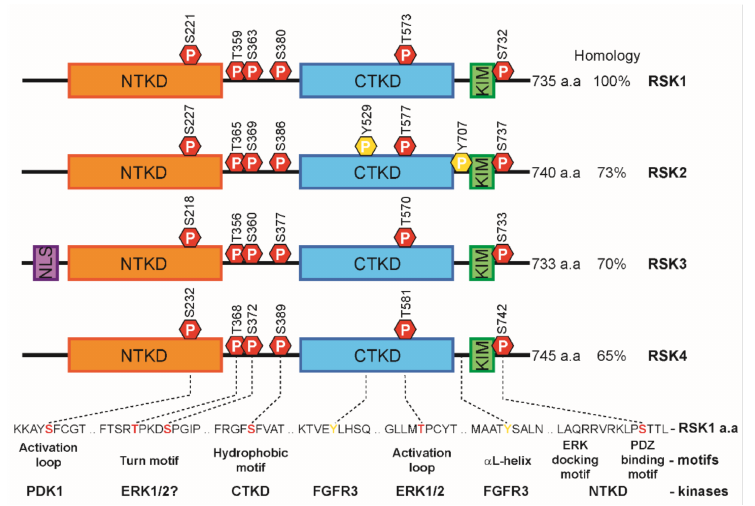
Figure 2. The domain structure of four RSK isoforms in human. RSKs exhibit two functional domains NTKD and CTKD, which are connected by a linker region. RSKs have six conserved phosphorylation sites. C-terminal tail contains an ERK1/2-docking domain called KIM motif and PDZ-binding